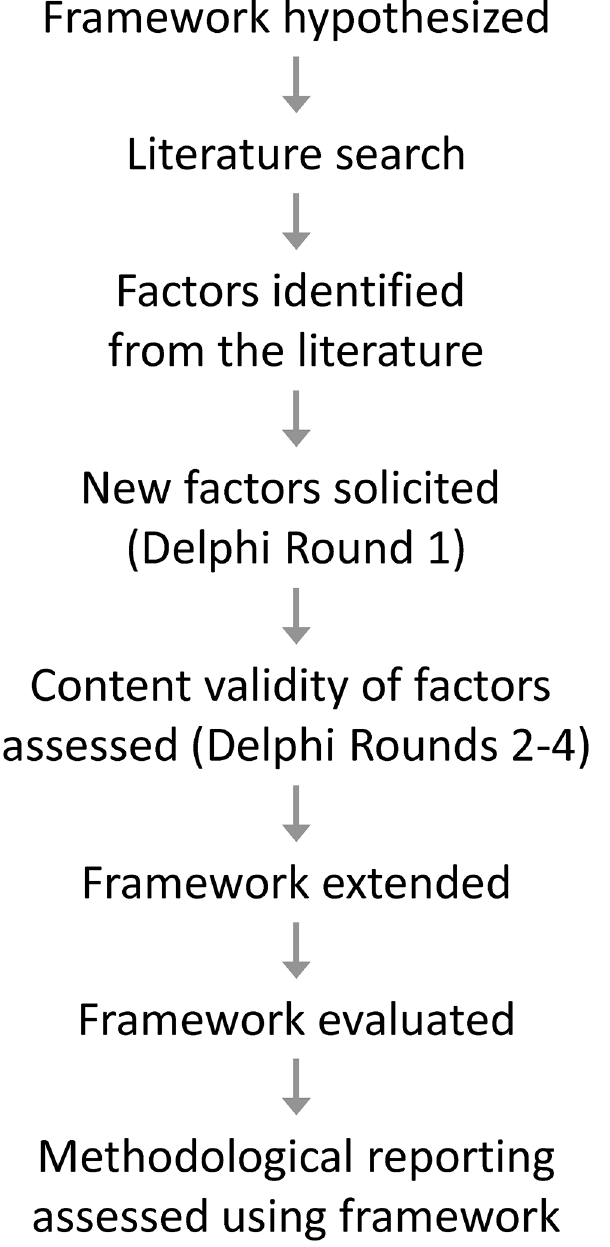
Fig 1. Overview of the research